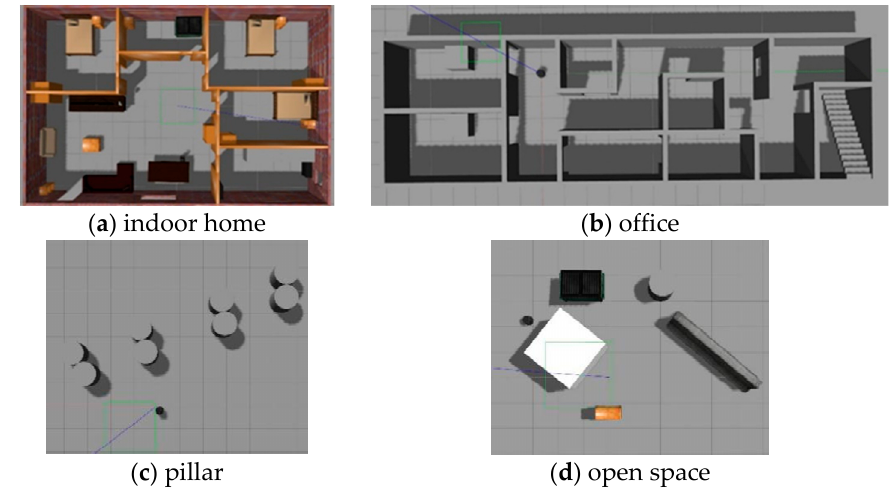
Figure 5. Simulation environment.